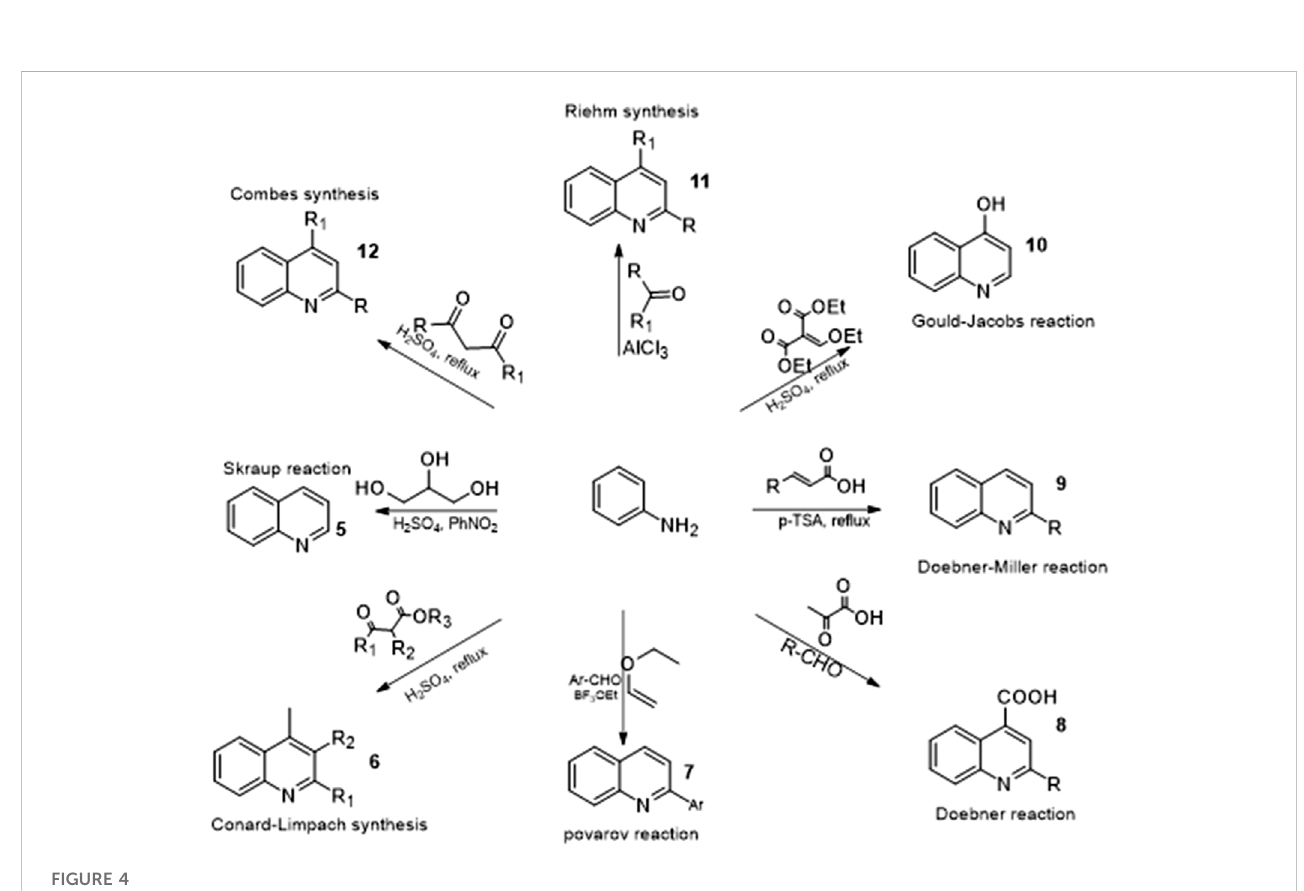
FIGURE 4 Classical synthetic route of